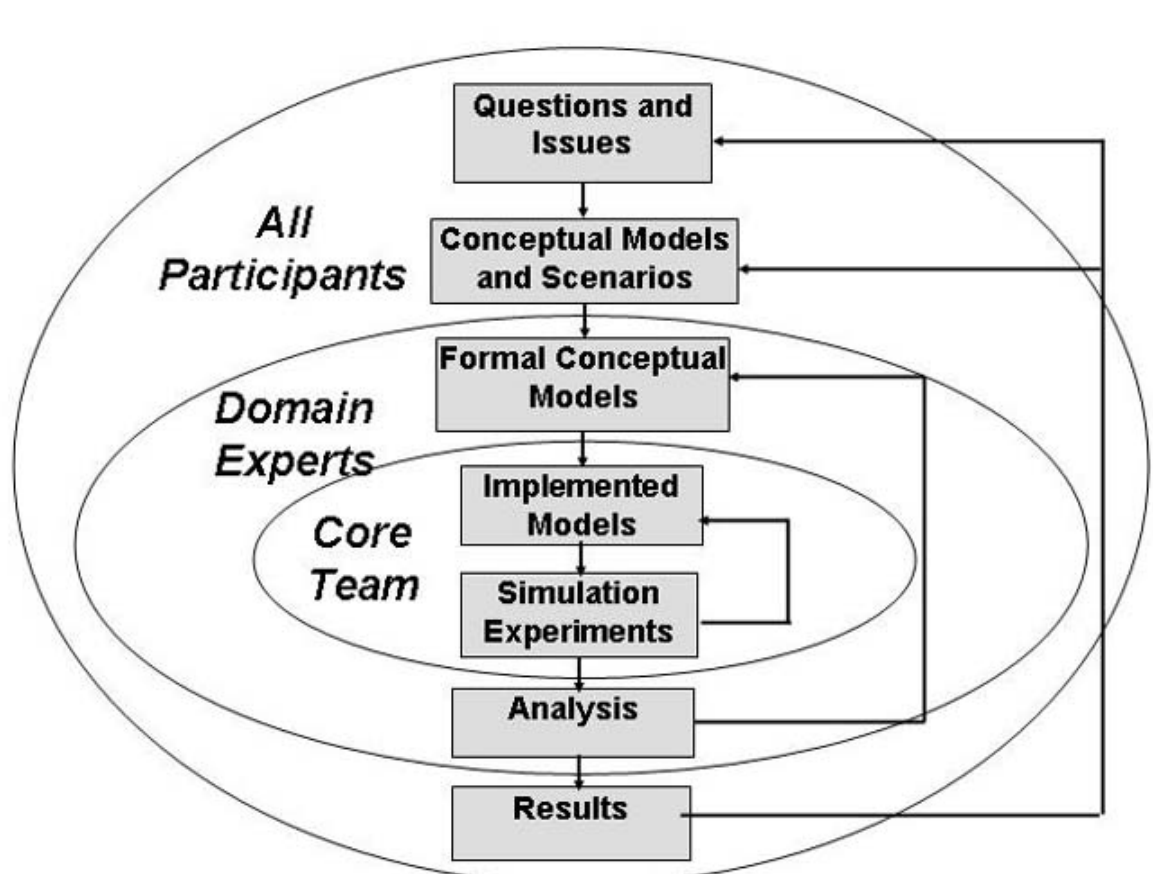
Fig. 2. The nested, iterative model development process proposed by Fall et al. (2001). Groups participate in all circles that surround them. The initial interest and desire for strategic SFM